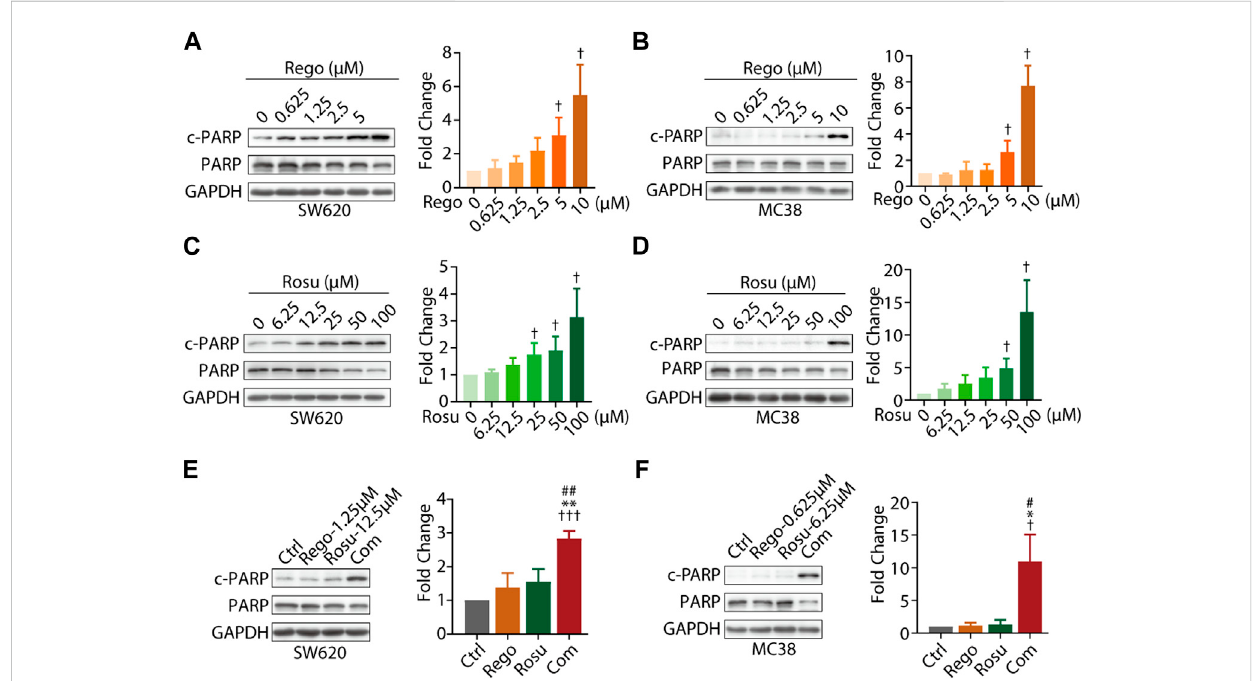
FIGURE 2 Combination regimen of regorafenib/rosuvastatin synergistically induced cell apoptosis of colorectal cancer cells in vitro . (A – D) Immunoblotting analysis cellular c-PARP/PARP expression levels of SW620 and MC38 cells treated with different concentration of regorafenib (range, 0.625 – 10 μ M) or rosuvastatin (range, 6.25 – 100 μ M) for 24 h. (E, F) Immunoblotting analysis on cellular c-PARP/PARP expression levels of SW620 and MC38 cells treated regorafenib (1.25 μ Mand0.625 μ M,respectively),rosuvastatin(12.5 μ Mand6.25 μ M,respectively) orcombinationaltreatment for24 h.The density measurement of immunoblotting analysis was performed by ImageJ. Indicated protein levels were determined relative to GAPDH protein levels and normalized relative to control cells. The data are shown as mean ± SD of three replicates assays. † /*/#, p < 0.05; **/##, p < 0.01; ††† , p < 0.001 ( † . vs. Control group; *: vs. Regorafenib group; #: vs. Rosuvastatin group). Rosu: Rosuvastatin; Rego: Regorafenib; Com: